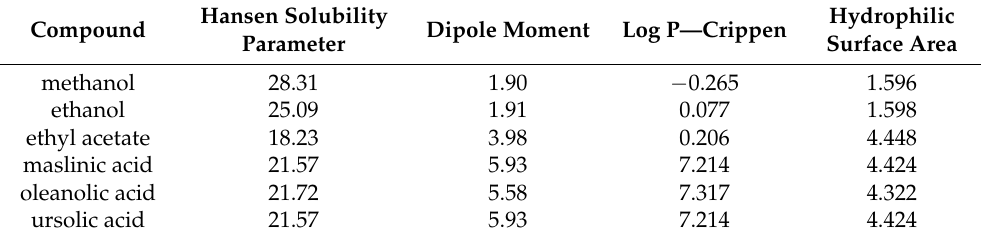
Hydrophilic Surface Area